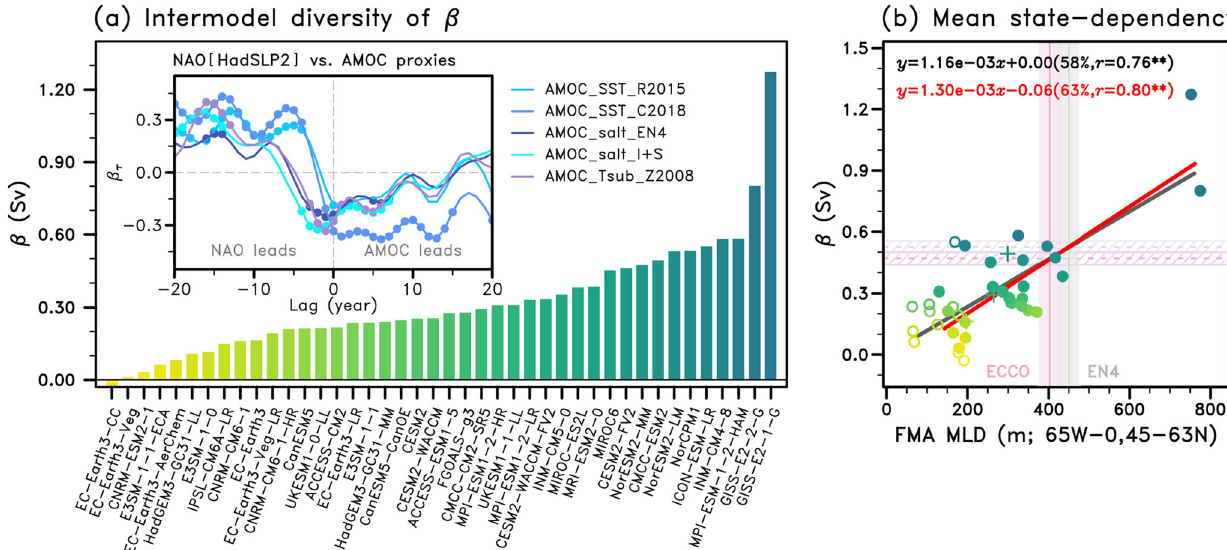
Fig. 1 Simulated/Estimated NAO – AMOC relationships and their mean state dependency. a The maximum regression coef fi cients ( β ; unit: Sv; 1 Sv = 10 6 m 3 s − 1 ) when the NAO leads the AMOC by less than 10 years for each model (both 5-year fi ltered; see Methods and Supplementary Fig. 2). The inset shows lagged regression coef fi cients ( β τ ; unitless) of various AMOC indicators on the observed NAO index where τ indicates a lag (Methods). b A scatterplot of FMA-season climatological mean SPNA MLD (unit: m) and β . Color code for individual models follows that of ( a ). Regression slope for all available models is shown in black, and red is for Group 2 (closed circles) only. Open circles and crosses are for Group 1 and 3. The equations at the top left correspond to each regression line that has the same color. In the parenthesis, the goodness of fi t ( R 2 ; in %) and the Pearson correlation coef fi cient ( r ) are shown. The range of observed/observation-constrained MLD (Methods) is shown by vertical solid line with a 95% con fi dence interval (shaded). Based on the established relationship from CMIP6 (black line and equation), β is estimated for the observed MLD (dashed line and hatched area); gray for EN4 and pink for ECCO datasets. The bold dots in the inset of ( a ) and the asterisk symbol ‘ ** ’ in ( b ) indicate statistically signi fi cant values at the 95% con fi dence level, which was evaluated using a two-tailed Student ’ s t test. In the inset, the effective sample size was considered